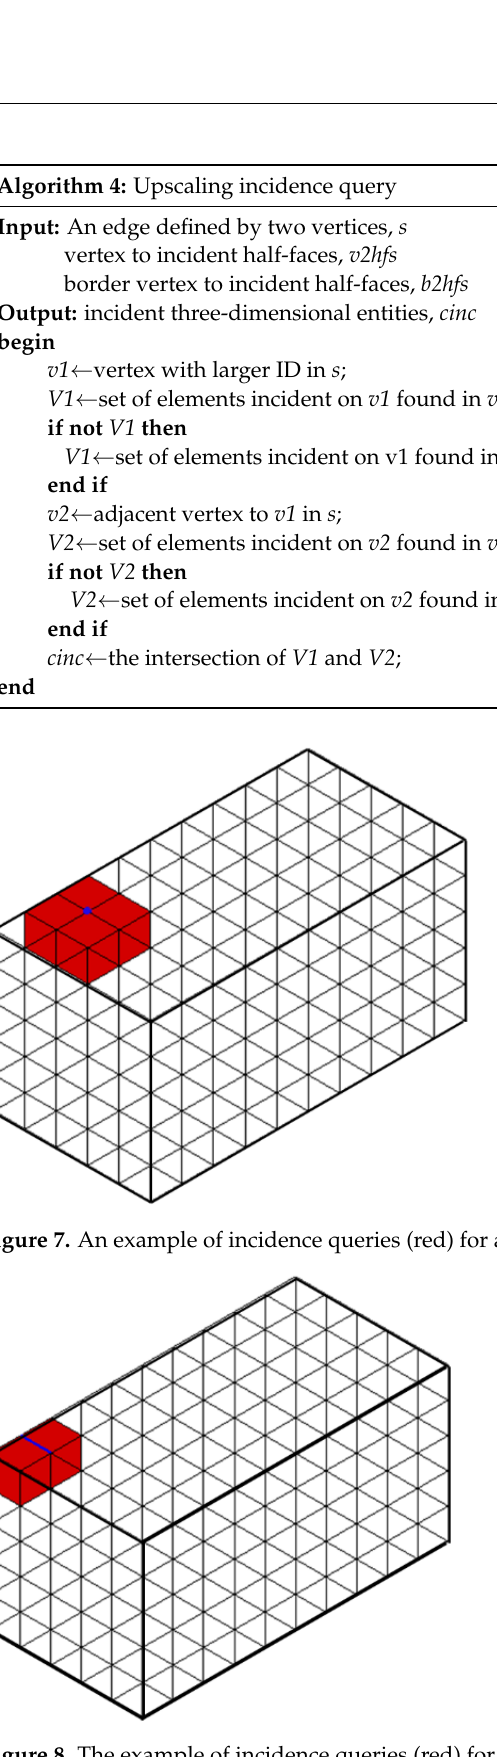
Figure 8. The example of incidence queries (red) for a given non-manifold edge (blue). The topology query results show that the proposed CAHF data structure is